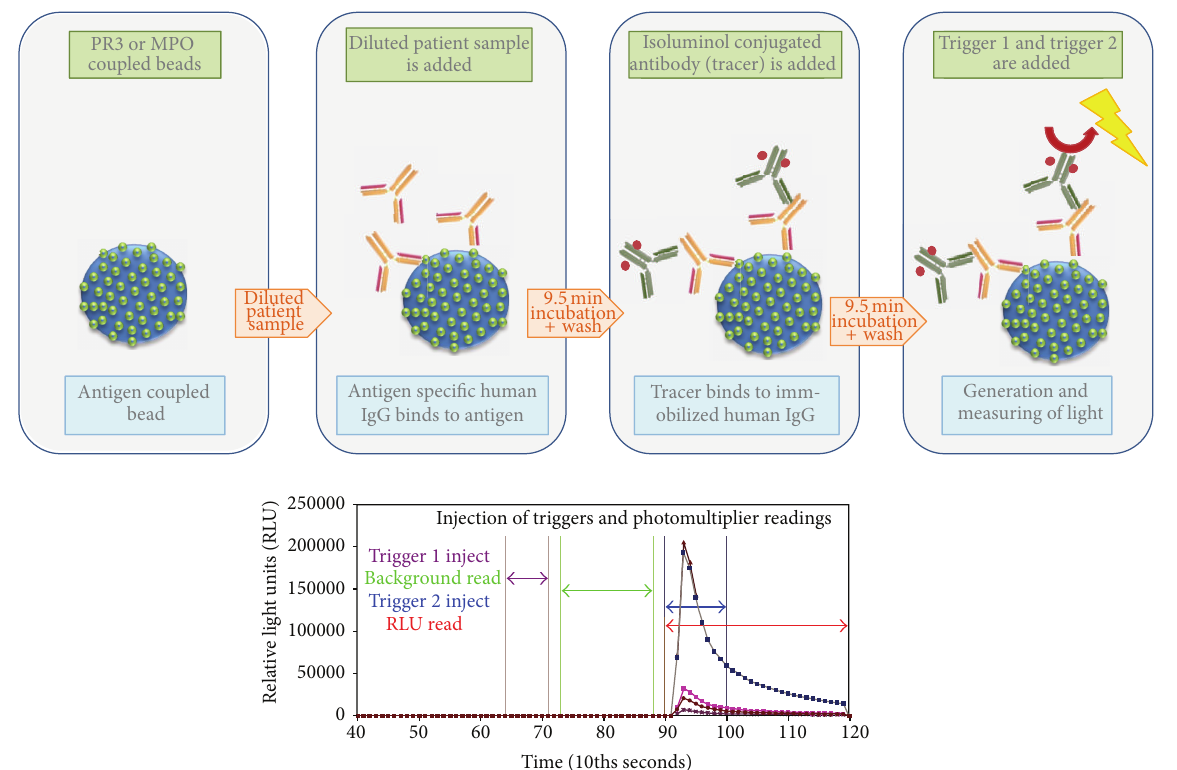
Figure 4: Principle of QUANTA-Flash chemiluminescent immunoassays. Paramagnetic beads are coupled with native PR3 or MPO. The beads are then incubated with diluted patient samples. After 9.5 min incubation unbound antibodies are removed by washing. Antihuman IgG isoluminol conjugate (Tracer) is added and binds immobilized antibodies. After another 9.5 min incubation unbound Tracer is removed by washing. Finally, Trigger 1 and Trigger 2 are injected and emerging light is measured. After injection of Trigger 1 and Trigger 2, the luminescence is measured as relative luminescence units (RLU) [17].